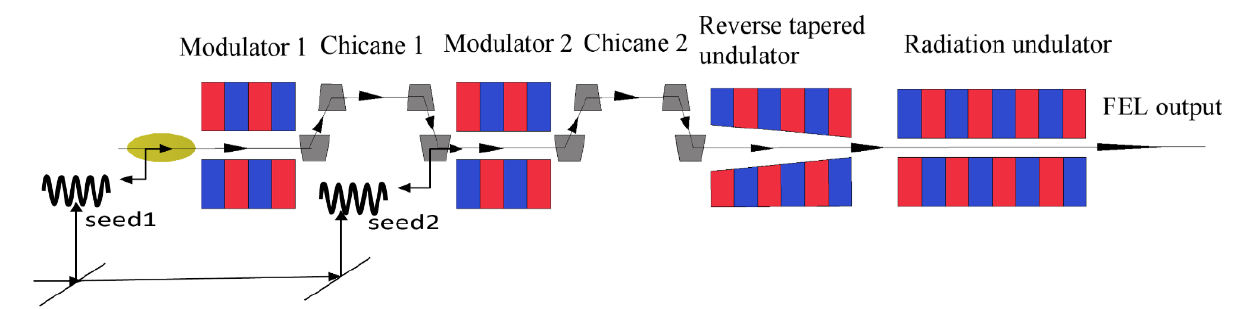
Figure 1. Schematic layout of the reverse taper enhanced harmonic cascade technique.